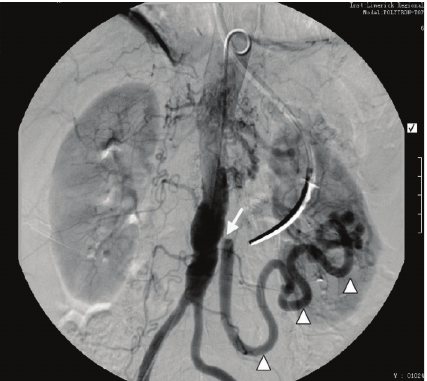
Figure 2: Preoperative aortogram with occlusion of the superior mesenteric artery and high grade stenosis of celiac and inferior mesenteric arteries (arrow). Note the markedly hypertrophied IMA which collateralises with the SMA via the marginal branch of Drummond (arrowheads) and the Arc of Riolan.